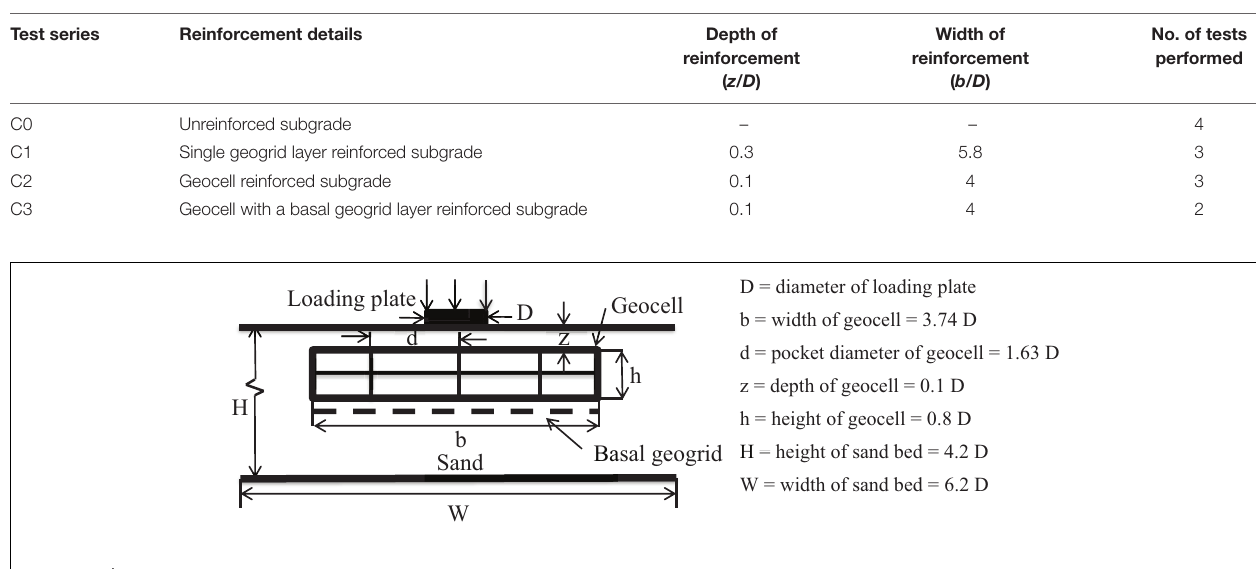
TABLE 2 | Test series for different reinforced subgrades.